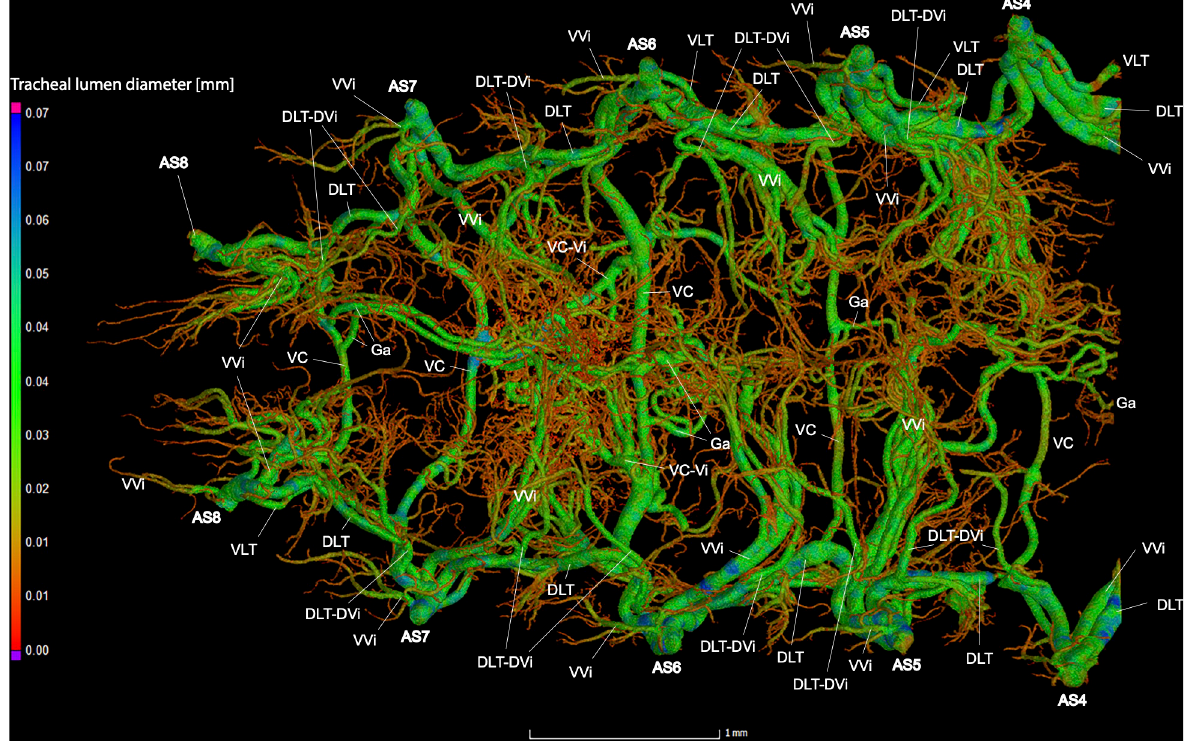
Fig 17. Dorsal view of the abdominal tracheal system in adult female Photinus pyralis .